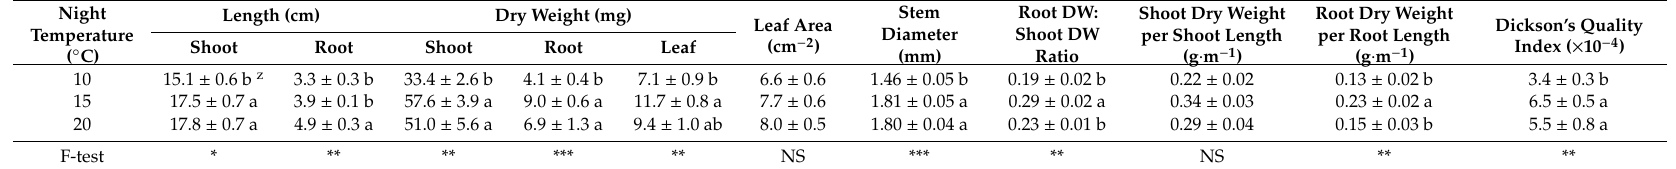
Table 2. E ff ect of night temperature on the growth parameters of C. lanceolata plug